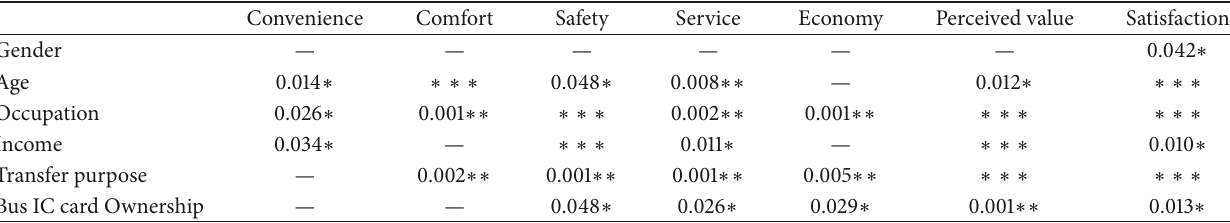
Table 8: Effects of the passengers’ socioeconomic attributes on their